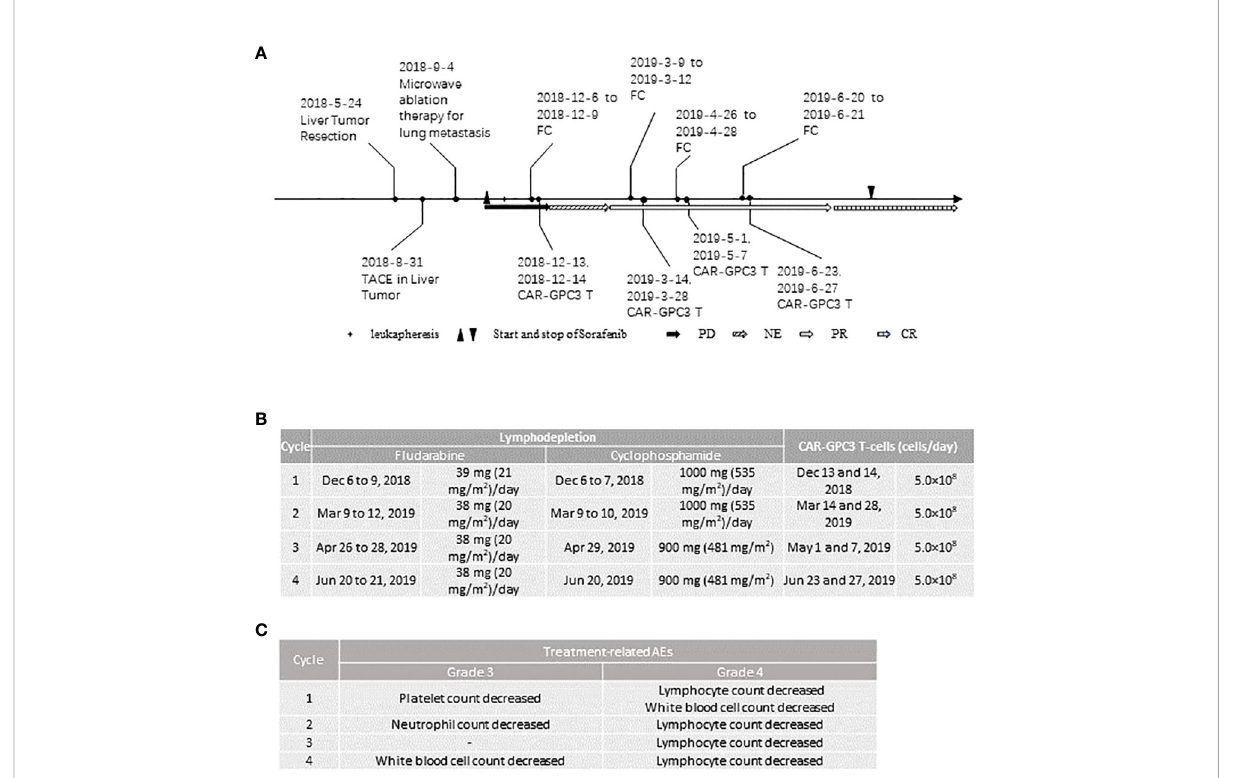
FIGURE 1 Clinical activities of the patient: (A) , Therapies and their responses; (B) , Dose of preconditioning treatment and CAR-GPC3 T-cells in each cycle; (C) , All the grade 3 and 4 treatment-related adverse events in each cycle. PD, progression disease; NE, not evaluable; PR, partial response; CR, complete